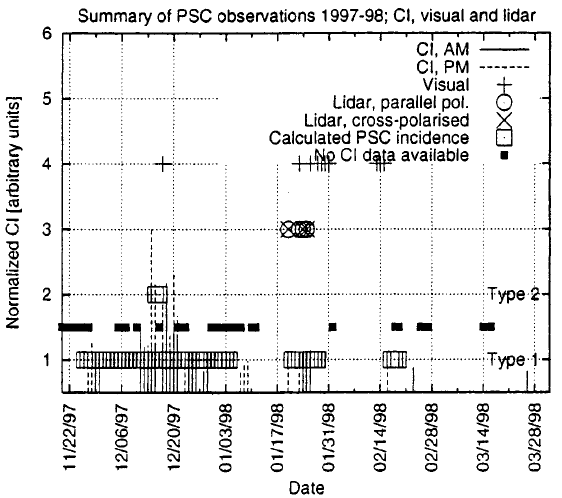
Table 3. Interpretation of lidar data Observation Composition Low backscatter ratio, parallel